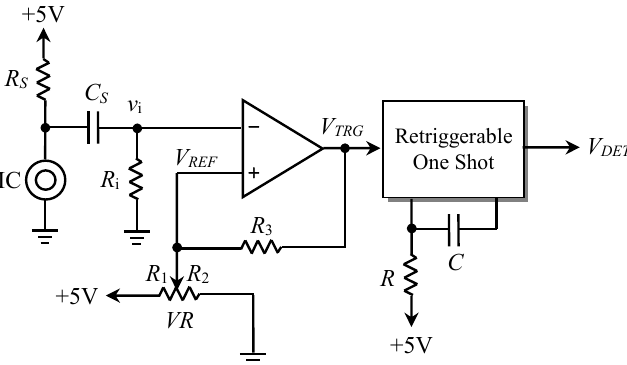
Figure 4. The circuit for blowing signal sensing and conversion.